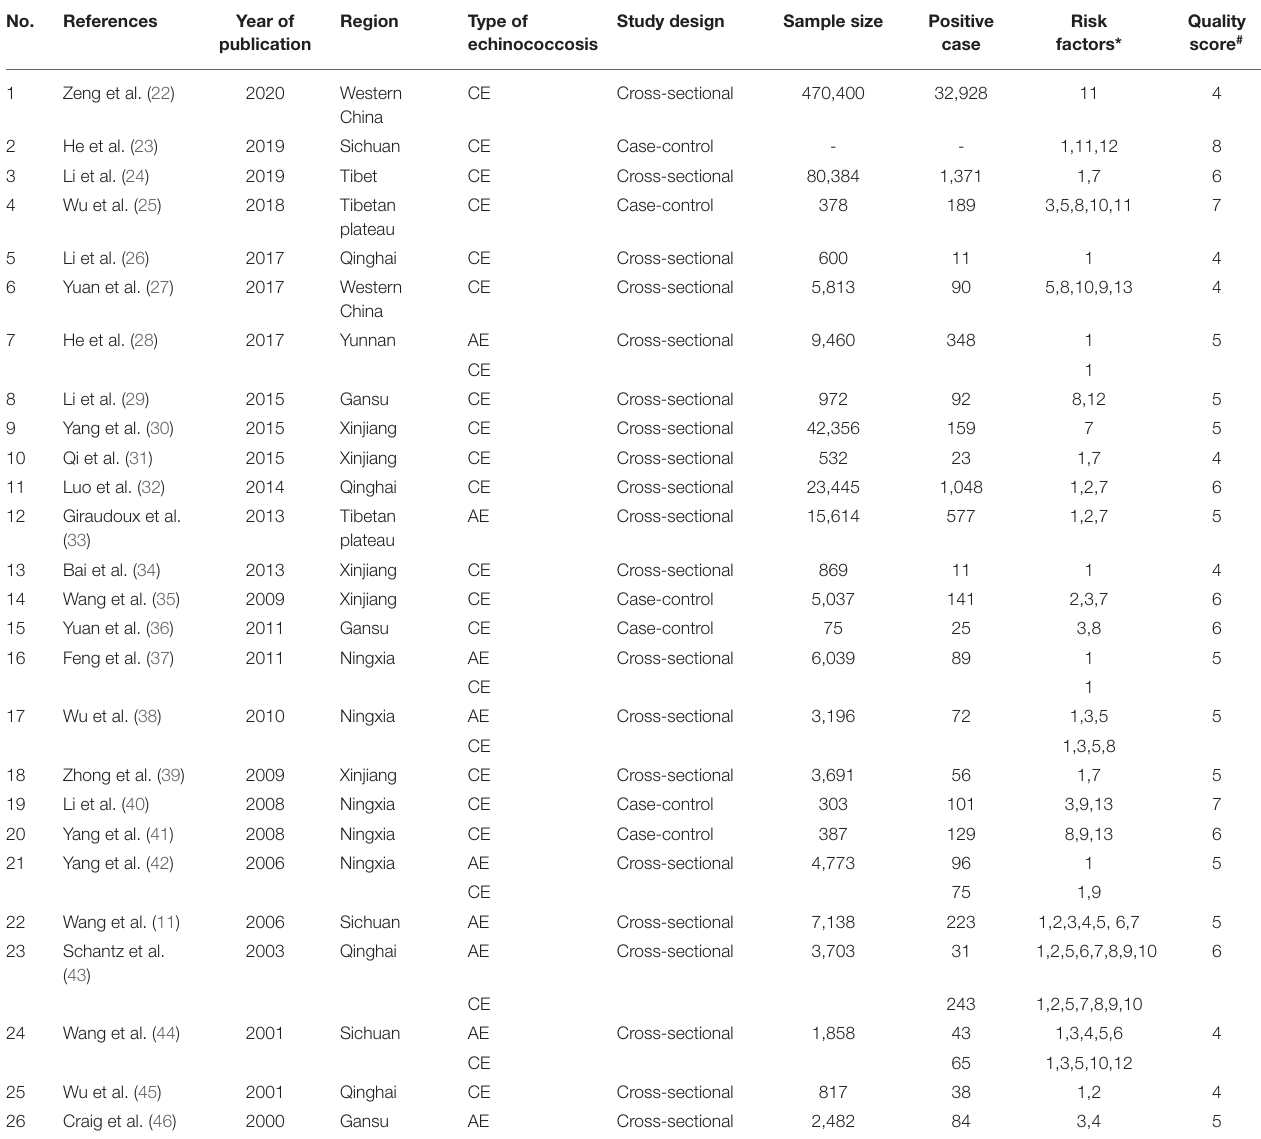
TABLE 1 | Main characteristics of the included